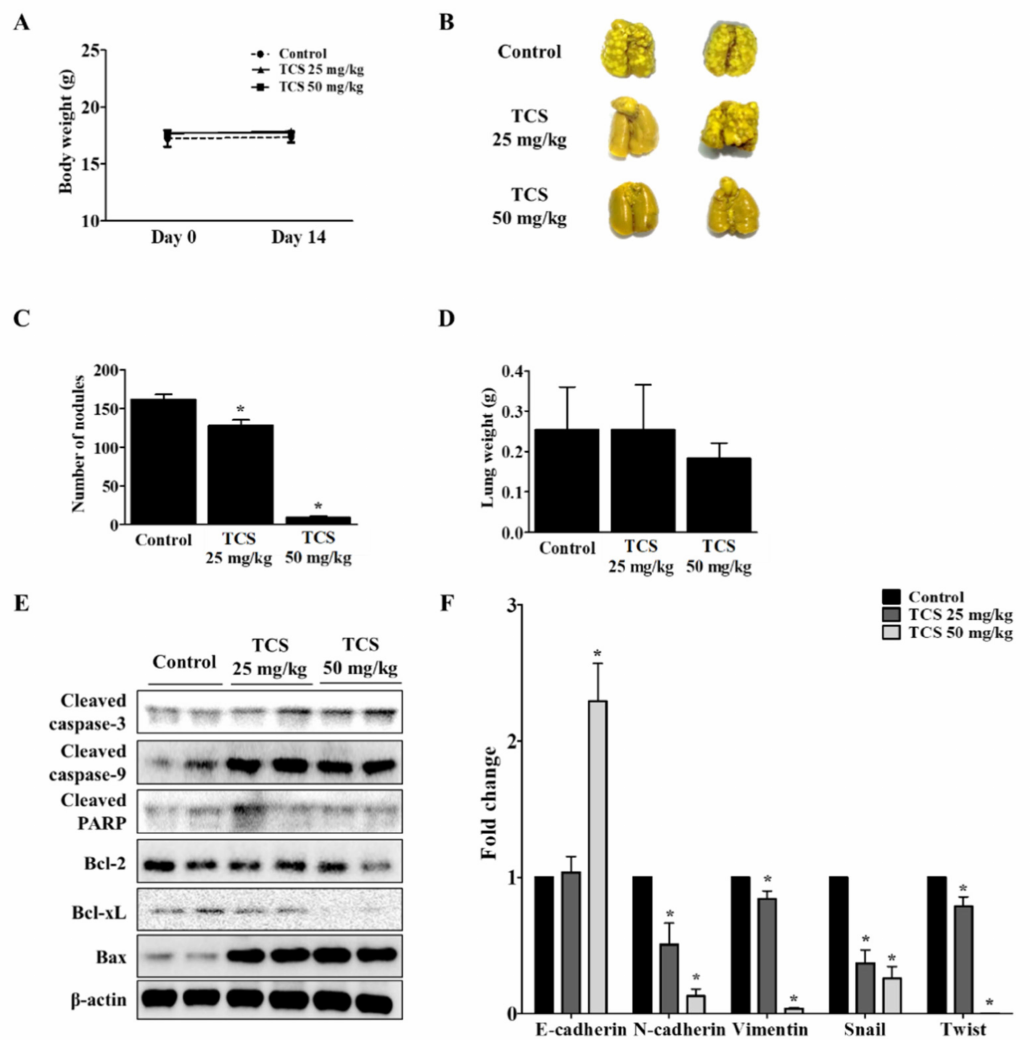
Figure 8. TCS inhibits colorectal lung metastasis. The mice were divided into three groups ( n = 7 for control, n = 6 for TCS treatment groups) and subjected to oral administration of TCS at 25 and 50 mg/kg once a day until sacrifice. For the control group, the mice were administered the same volume of 5% Kolliphor solution. ( A ) To assess the toxicity of TCS, the body weight of the mice was monitored. ( B ) Pulmonary tumor nodule formation. ( C ) Number of tumor nodules. ( D ) Lung weight after sacrifice. ( E ) Apoptosis-related proteins in lung tissues were analyzed by Western blotting. ( F ) mRNA expression level of EMT transition markers were analyzed in lung tissues by real-time qRT-PCR. Data are expressed as the mean ± SD of three independent experiments. * p <